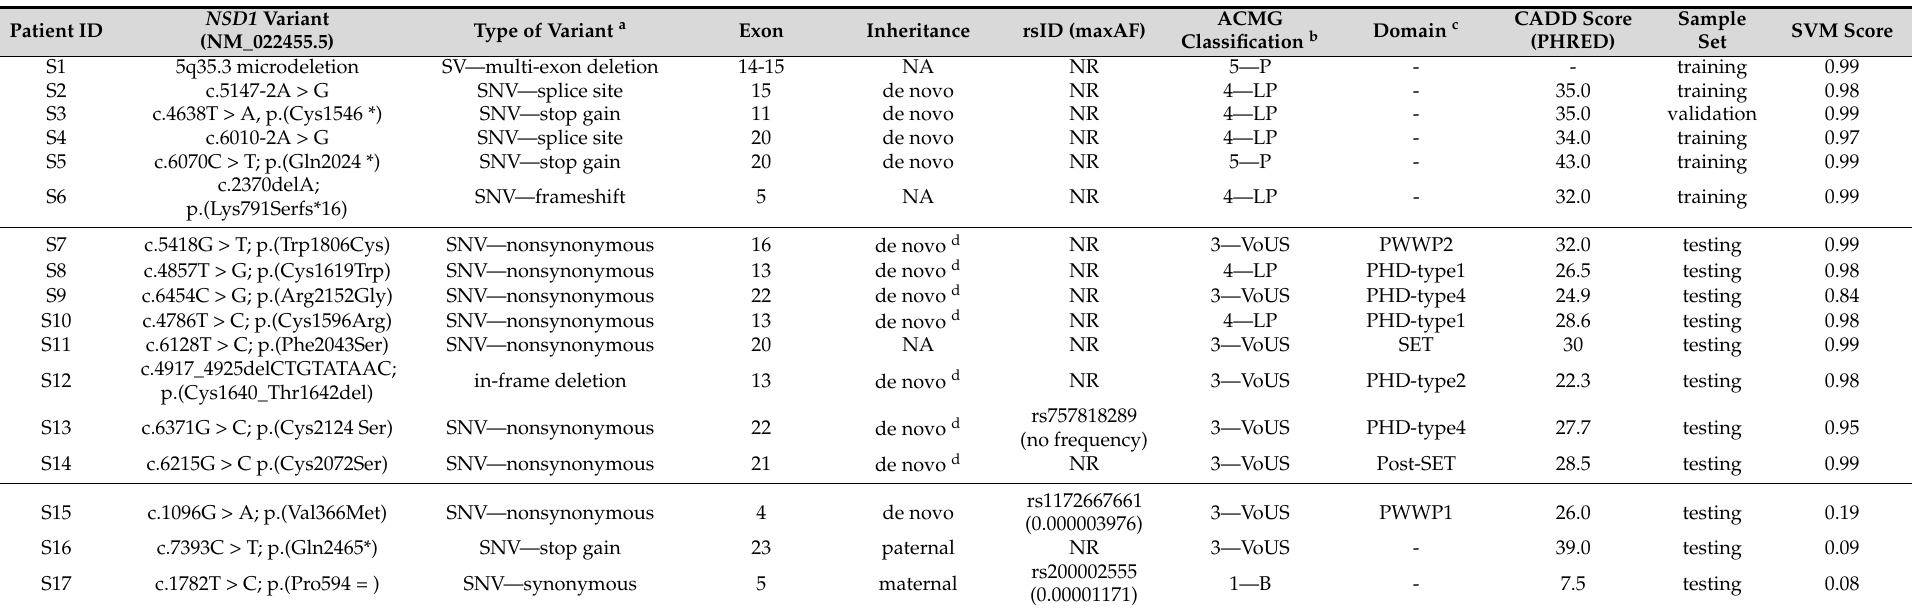
Table 2. Functional annotation of the NSD1 variants included in the study